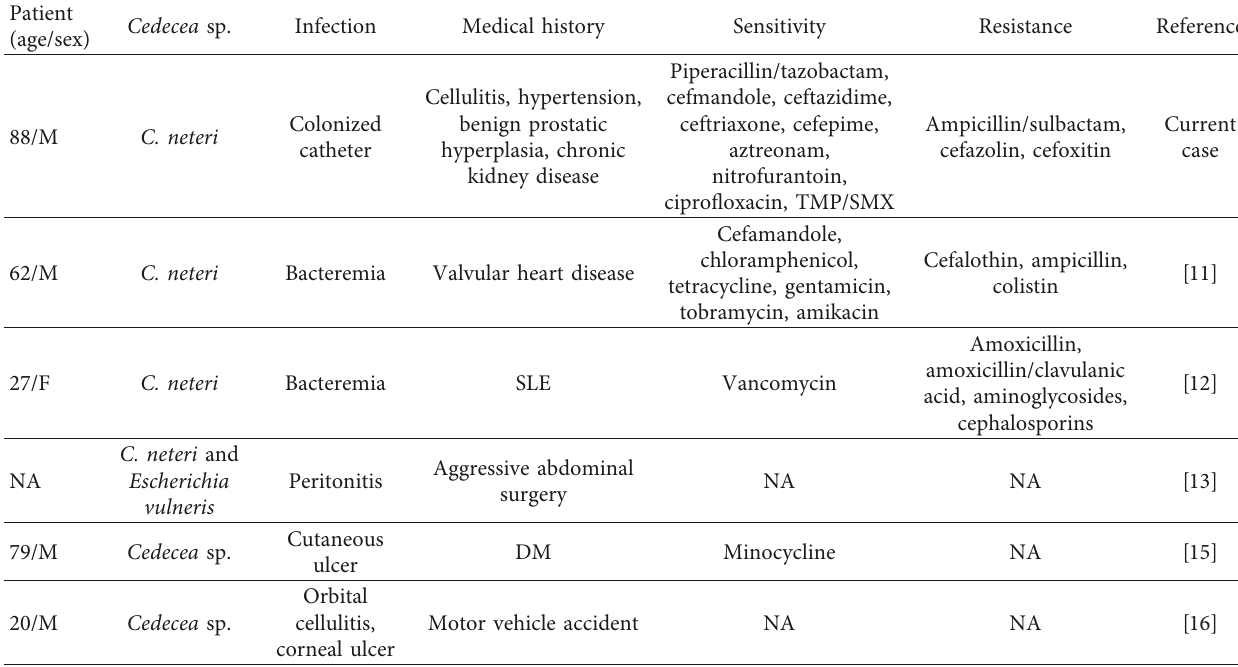
Table 1: Reported clinical cases involving Cedecea neteri and Cedecea